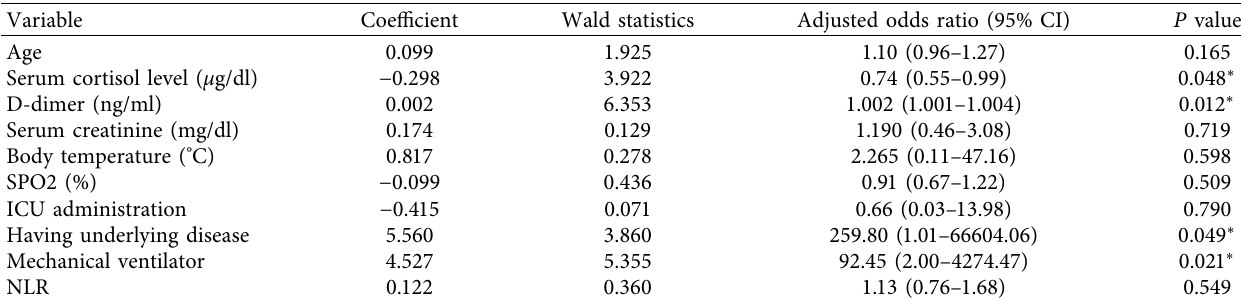
Table 3: Multivariate logistic regression analysis on factors related to death among patients with